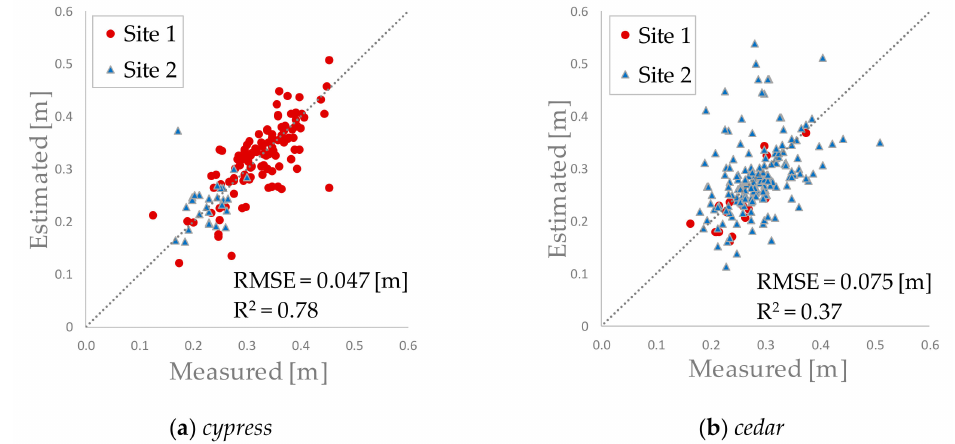
Figure 12. Comparison of DBH measurement and estimation. Each plot represents an individual tree. Color and shape of each plot show the study sites. A diagonal line means that measured and estimated DBH is